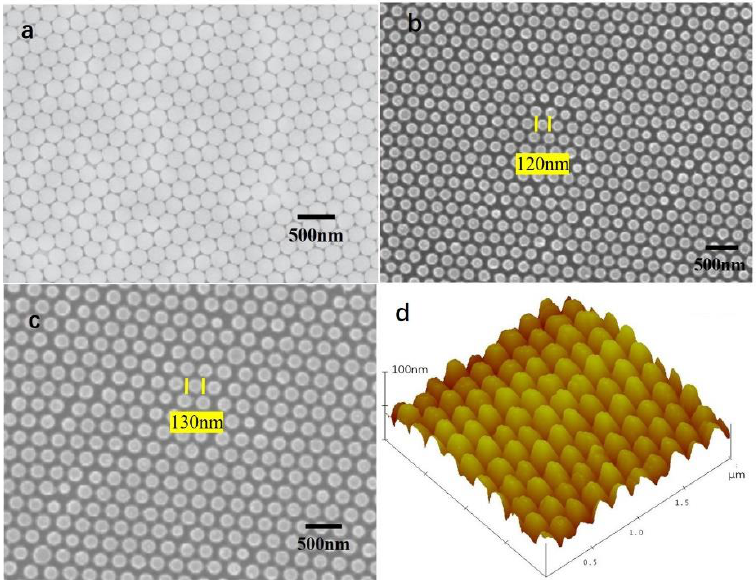
Figure 1. ( a ) Scanning electron microscopy (SEM) image of the ordered polystyrene (PS) sphere array. ( b ) SEM image of the silicon nanopillar array. ( c ) SEM image of the silicon nanopillar array with SnO 2 . ( d ) Atomic force microscopy (AFM) image of the silicon nanopillar array with SnO 2 .